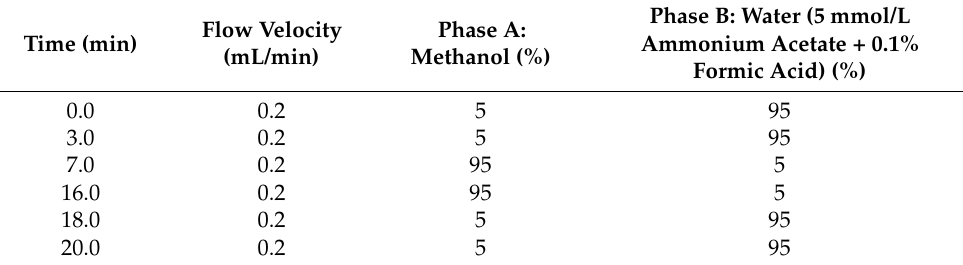
Table 1. Mobile phase and gradient elution